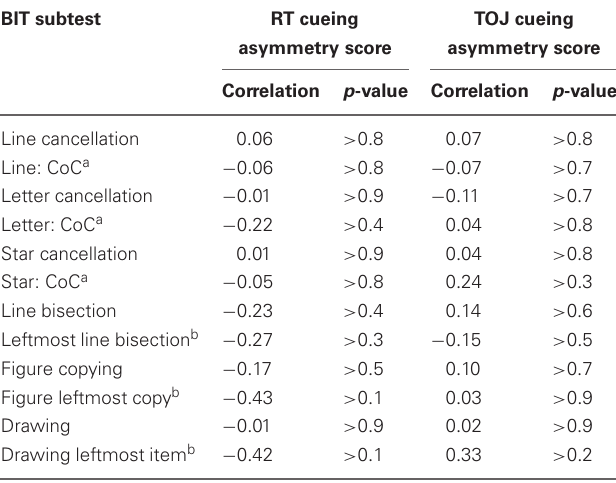
Table 3 includes the descriptive statistics for left- and right-side target CEs based on error rates as well as the cueing asymmetry scores (see section “ Methods of Analysis ”,